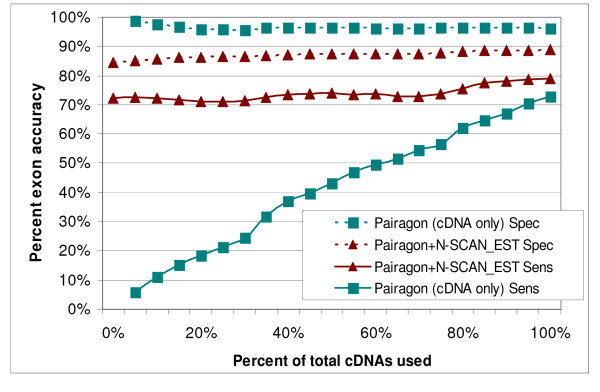
Accuracy of Pairagon cDNA alignments alone compared to Pairagon+N-SCAN_EST as a function of the number of cDNAs used. A total of 445 cDNAs aligned to the 31 human ENCODE test regions. The x axis shows the percentage of these 445 that were used. From left to right, 5% of unused cDNAs were randomly picked and added to those used previously.